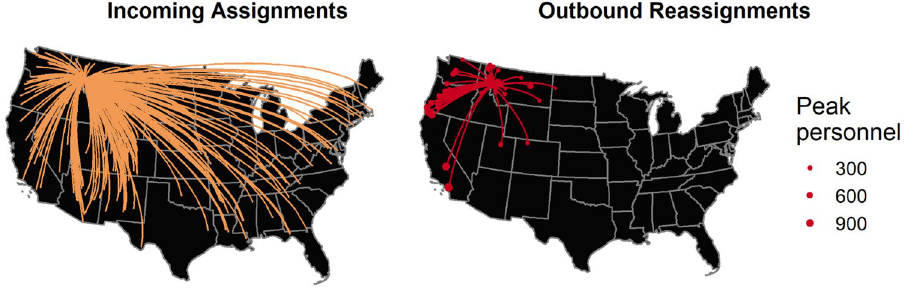
Figure 1. Historical assignment/reassignment data for a single fire in Montana. The map of incoming assignments shows the range of origins for personnel assigned to a fire that started on July 15, 2017. The outbound reassignments shown include all incidents to which personnel went, given nine or fewer days between demobilization at the first fire and mobilization at the second